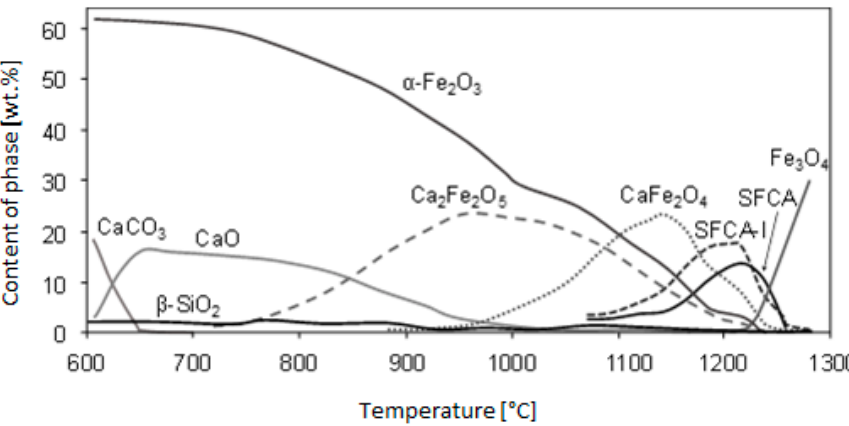
Figure 4. Course of calcium ferrite formation in agglomerate reproduced from [5], with permission from Webster, 2013.